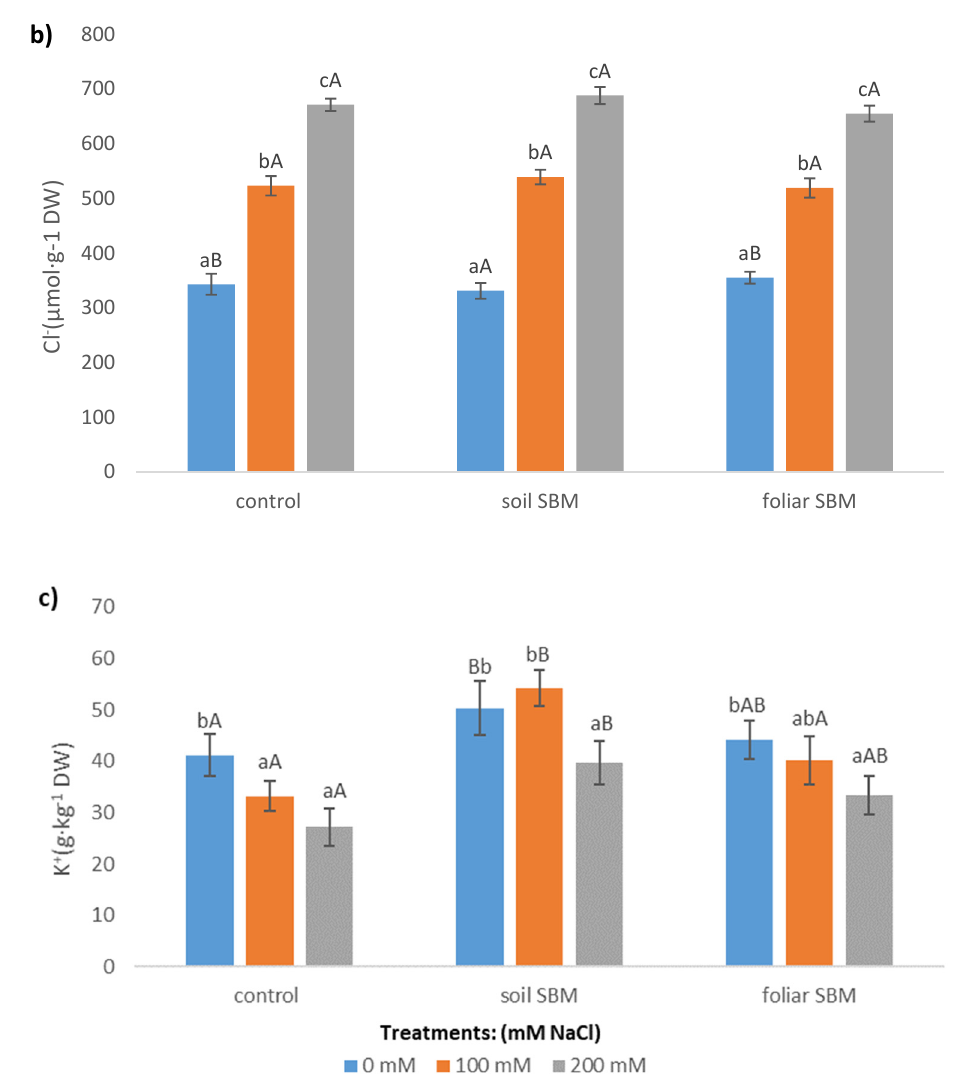
Figure 5. The sodium (Na + ) ( a ), chloride (Cl − ) ( b ), potassium (K + ) ( c ) concentrations in the shoots of the Thymus serpyllum plants after five weeks of salt stress and sugar beet molasses treatments (soil SBM—sugar beet molasses applied to the soil; foliar SBM—shoot application of sugar beet molasses). Values shown are means ± SD (n = 7). For each variant of the experiment, lowercase letters indicate significant differences between NaCl level and different capital letters indicate significant differences between each variant experiment for the same NaCl level, according to Tukey’s test ( α = 0.05).